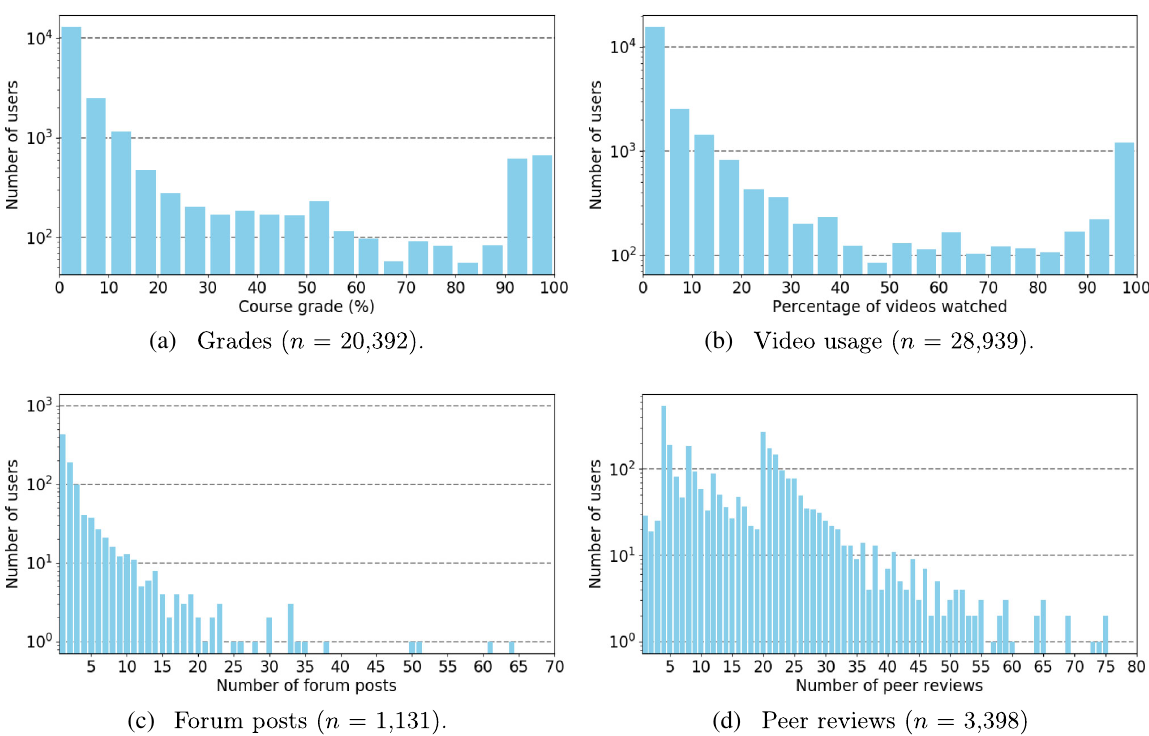
FIG. 1. Histograms for the distributions of (a) grades for learners who did at least one graded assignment, (b) video usage for learners who watched at least one video, (c) forum posts for learners who engaged in the discussion forum, (d) peer reviews for learners who participated in the peer reviewed